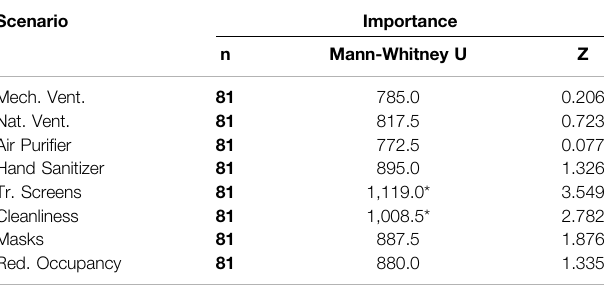
* Indicates signi fi cant results at p <